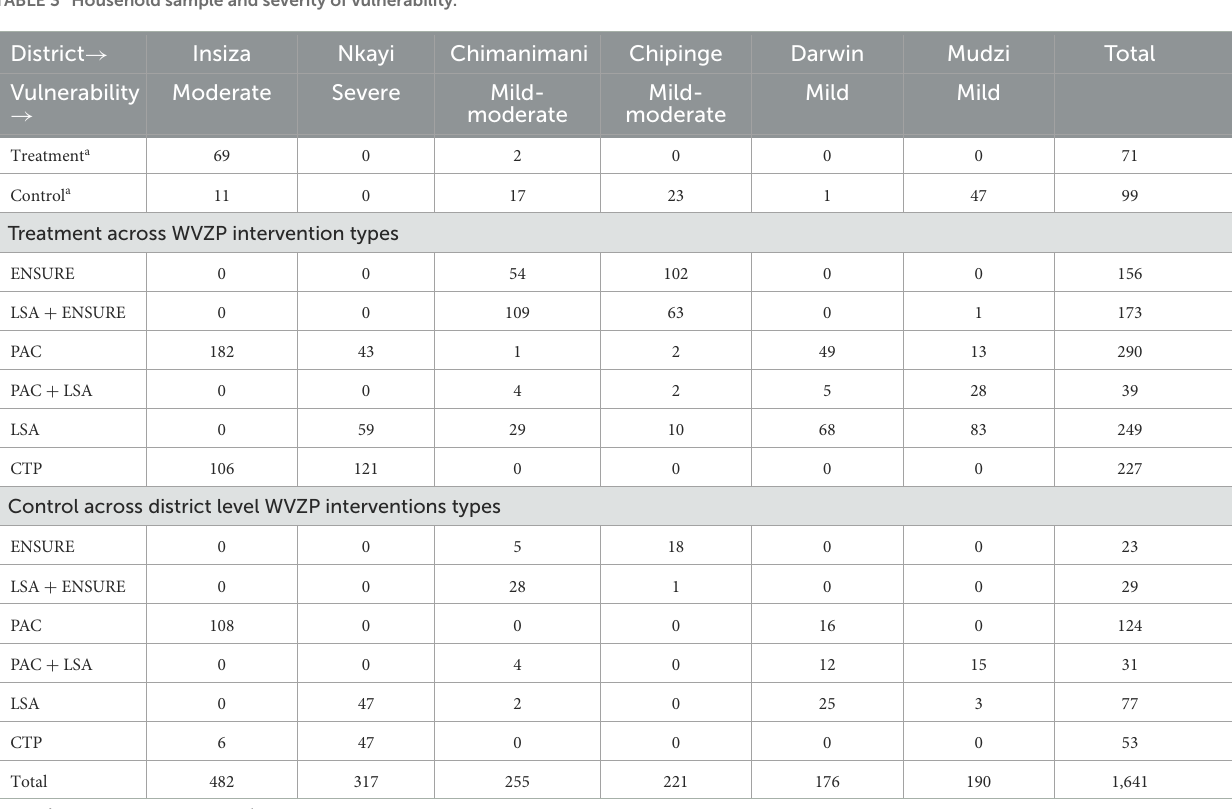
TABLE 3 Household sample and severity of